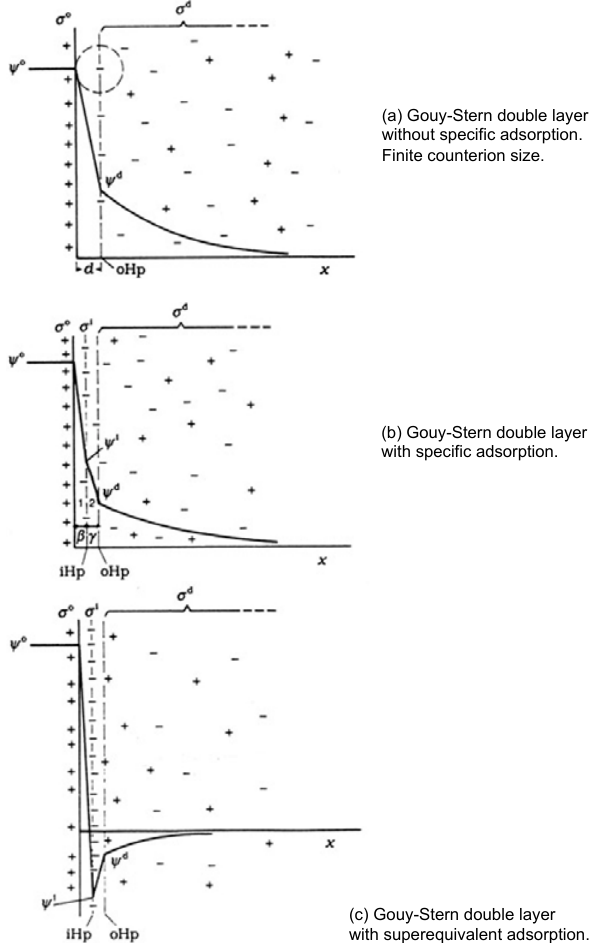
Figure 6. Actual view of Gouy-Stern double layers. Taken from Ref. 19 with permission. Copyright © 1995 Academic Press. Published by Elsevier. Discussion in the